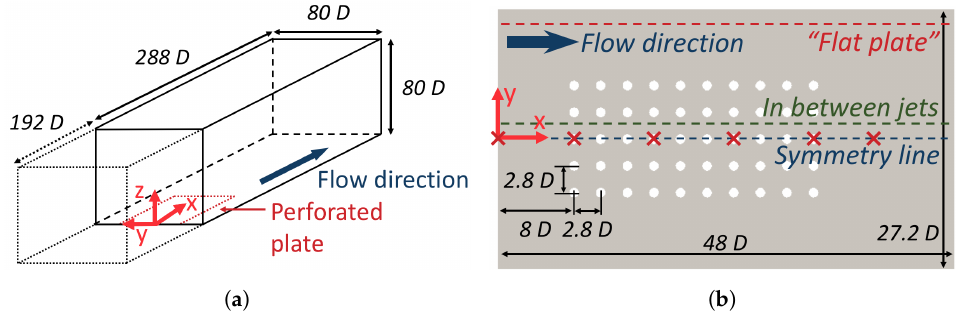
Figure 1. Test section geometry. ( a ) test section (solid and dashed lines) and numerical domain (solid lines only); ( b ) perforated plate dimensions. × : positions of the profiles provided in Figures 10 and